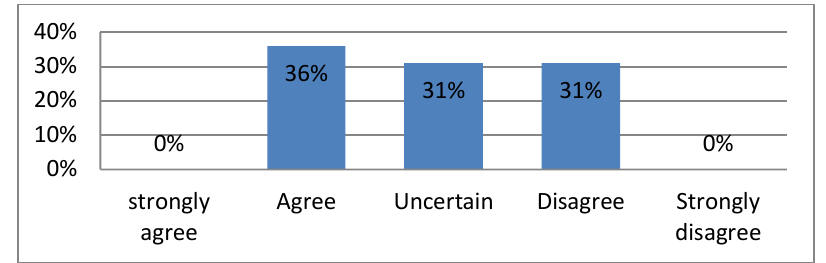
Figure 4 : purchase goods which are not in much use after seeing the advertisement.